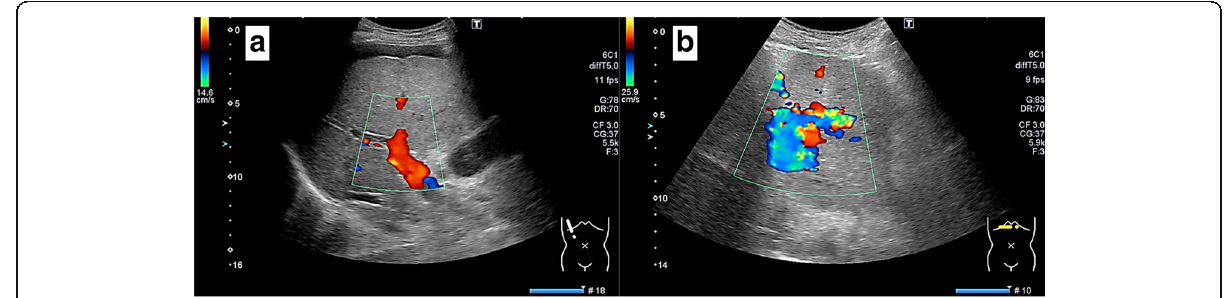
Fig. 1 Color Doppler ultrasonography findings. a Hepatopetal flow was shown in the right branch of the portal vein. b Hepatofugal flow was shown in the left branch of the portal vein, and disturbed flow was shown around the left branch of the